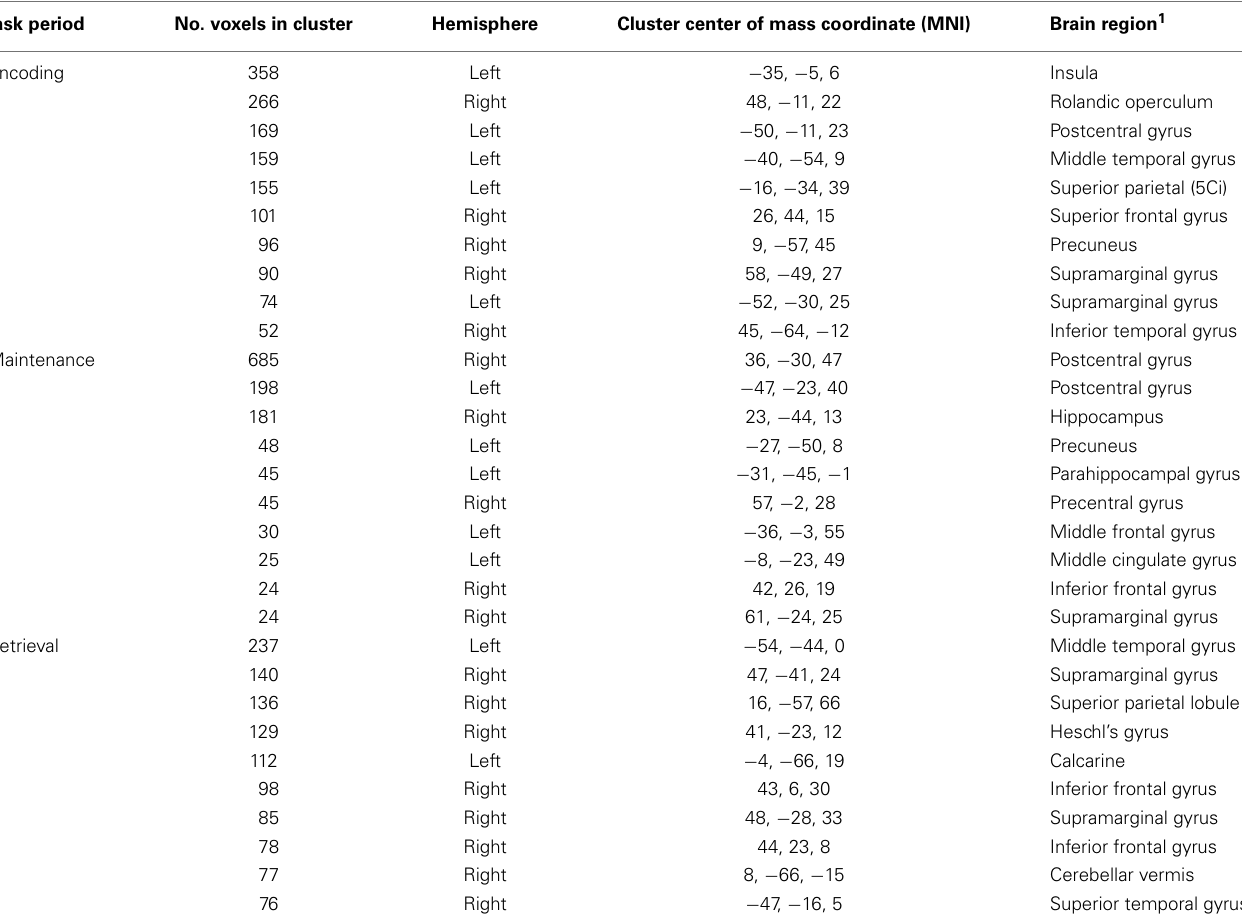
Table 2 | Between-group differences